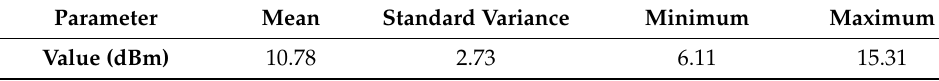
Table 4. Statistic parameter of the errors between the theoretical and measured